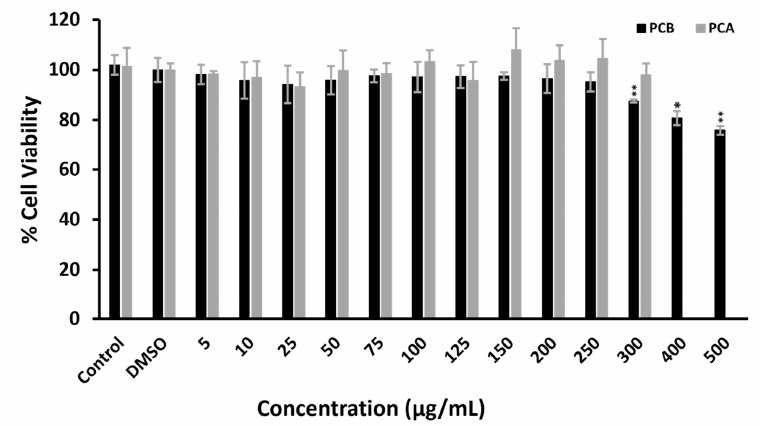
Figure 6. Cell viability of DLD1 cells under treatment with Pigment Complex A (PCA) and Pigment Complex B (PCB). Cells were treated with the indicated concentrations for 72 h. and the viability was estimated by the MTT assay. Control corresponds to the untreated cells and DMSO to the highest volume (0.5% v / v ) of DMSO which was added to the cells. Statistical analysis was conducted with the Dunnett’s test. ** p < 0.01. * p < 0.1.